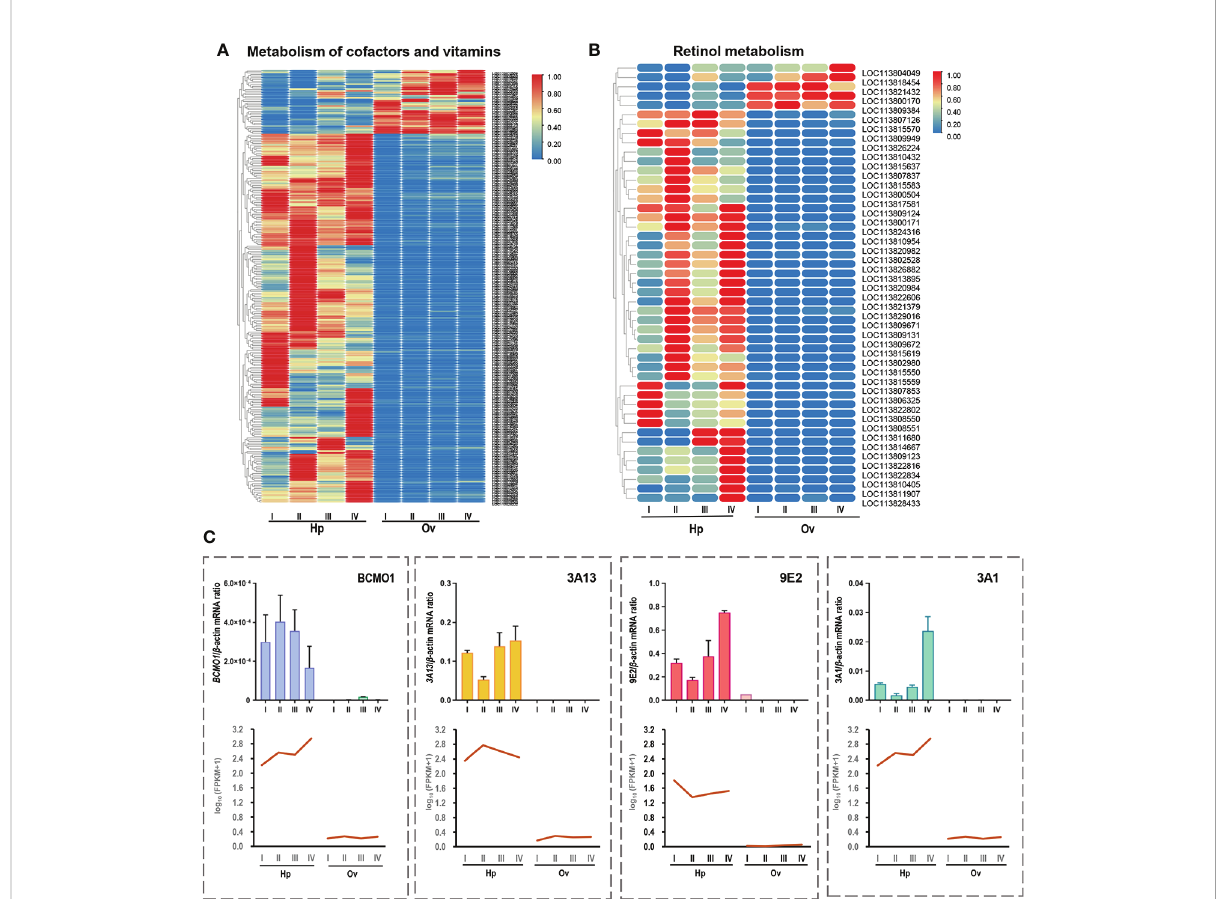
FIGURE 7 (A) Clustering heatmap analysis of vitamin metabolism genes in the primary pathway of carotenoid metabolism. (B) Clustering heatmap analysis of retinoid metabolism genes in the secondary pathway of carotenoid metabolism. (C) Realtime quantitative PCR validation of carotenoid metabolism-related RNA-seq data. Four representative genes were selected for validation, including beta, beta-carotene 15,15'-dioxygenase (BCMO1), cytochrome P450 3A13-like (3A13), cytochrome P450 3A1-like, transcript variant X1 (3A1) and cytochrome P450 9e2-like, transcript variant X1 (9E2). The X-axis represents developmental stages. Columns and bars represent the mean and standard error of the relative expression levels of RT-qPCR results (Y-axis on the left). Values with different superscripts indicate statistical signi fi cance (P < 0.05), calculated by one-way